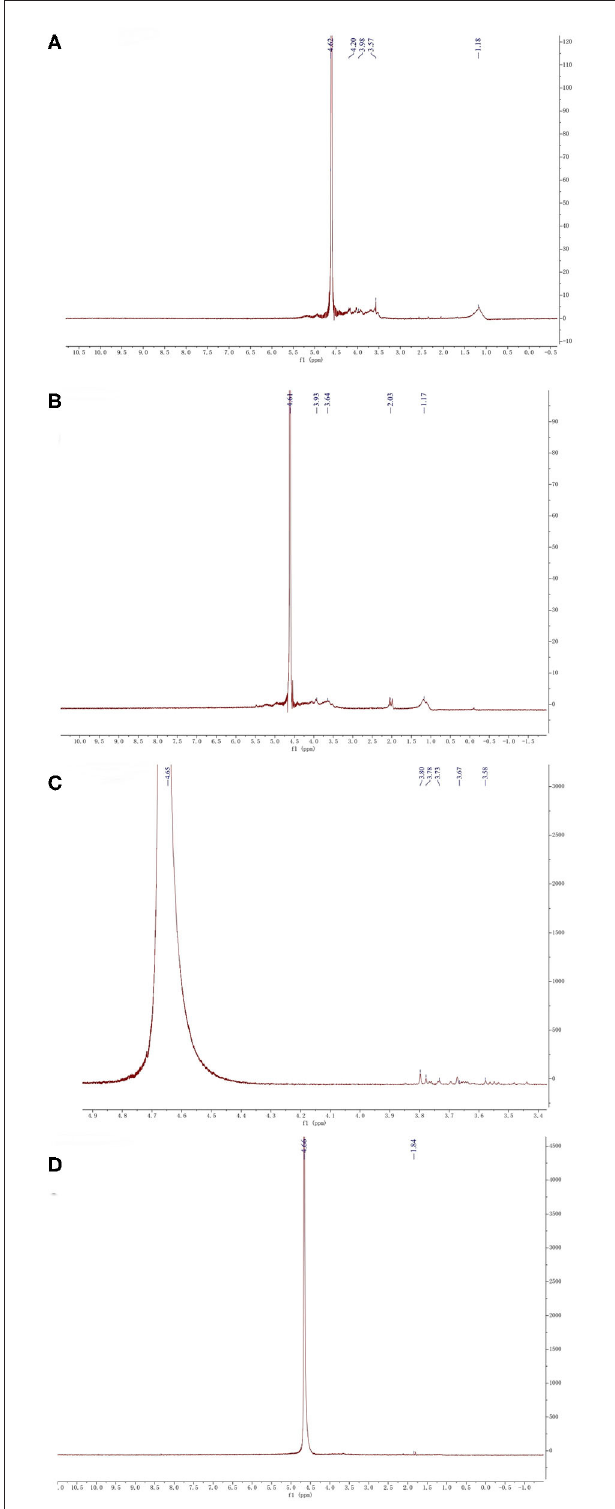
FIGURE 4 | 1 HNMR analysis of four fucoidan samples. 1 HNMR analysis of Fstd sample (A) , 1 HNMR analysis of WH sample (B) , 1 HNMR analysis of 300k sample (C) , 1 HNMR analysis of 10k sample (D)